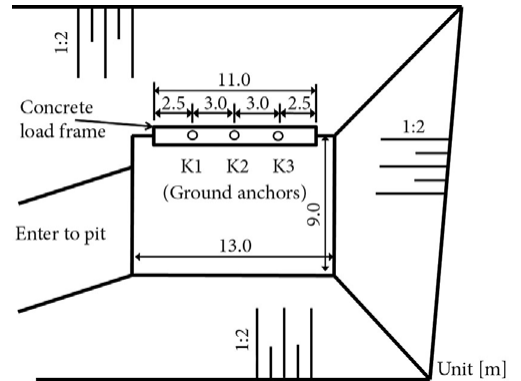
Fig. 1. Schematic ground plan of the test site Table 1. Tested anchor description Characteristic of anchor